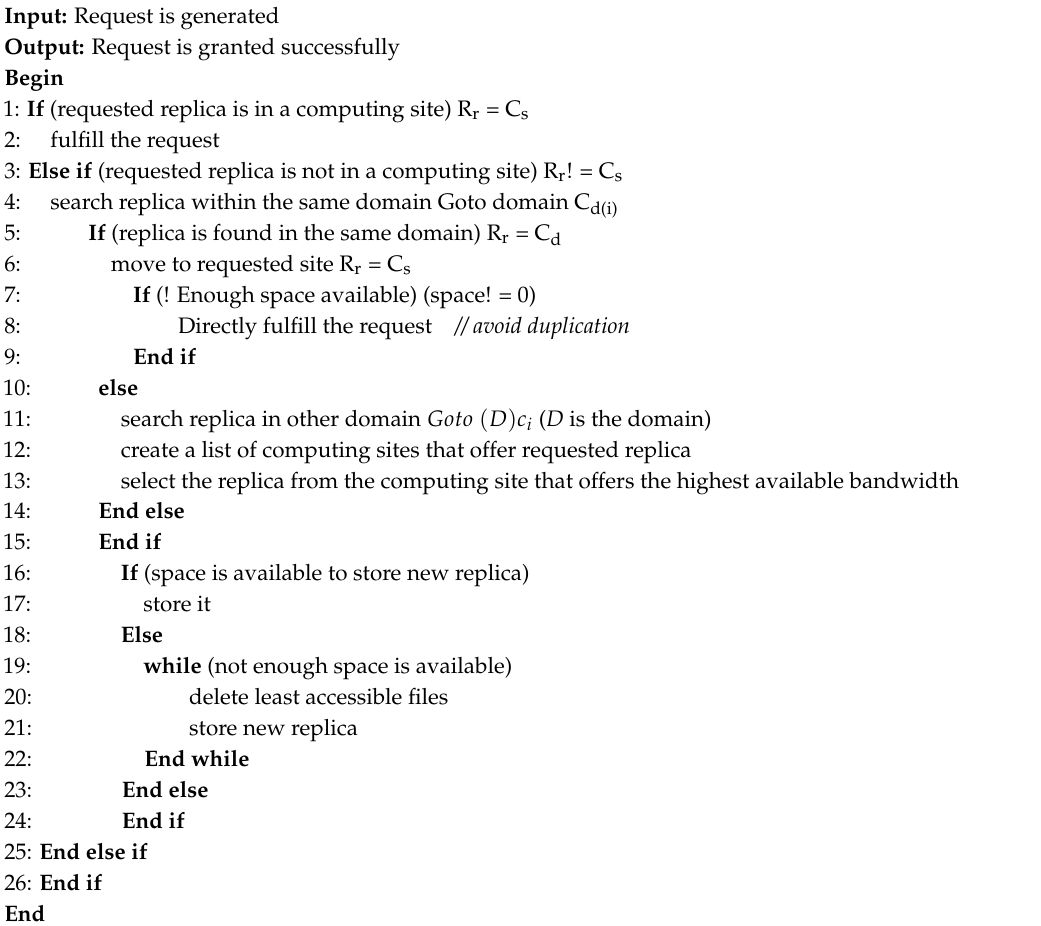
Algorithm 3: Schedule Enhancement